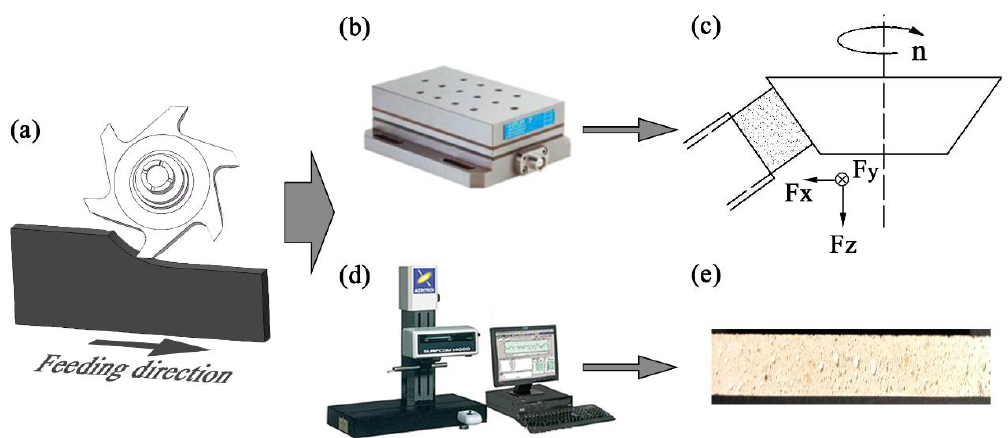
Figure 2. Schematic diagram of the cutting experiment: ( a ) tapered cutting, ( b ) dynamometer, ( c ) cutting force diagram, ( d ) surface profiler, ( e ) machined surface.